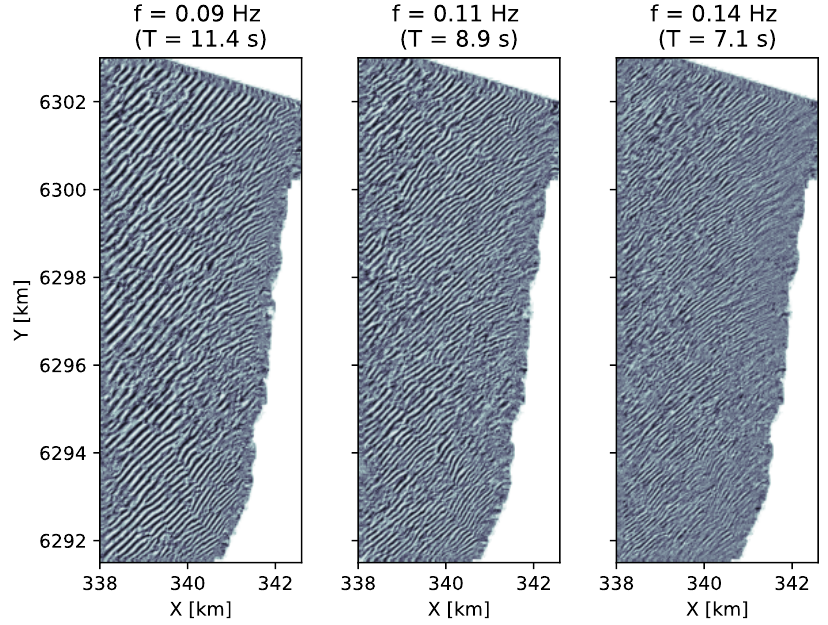
Figure 4. Global one-component phase images (GOCPI) of dominant frequency components f = 0.09,0.11,0.14Hz in the reconstructed video. The phase images are naturally retrieved via the Dynamic Mode Decomposition as part of the depth inversion procedure [13]. In total,nine phase images are used for analysis, of which three are presented as